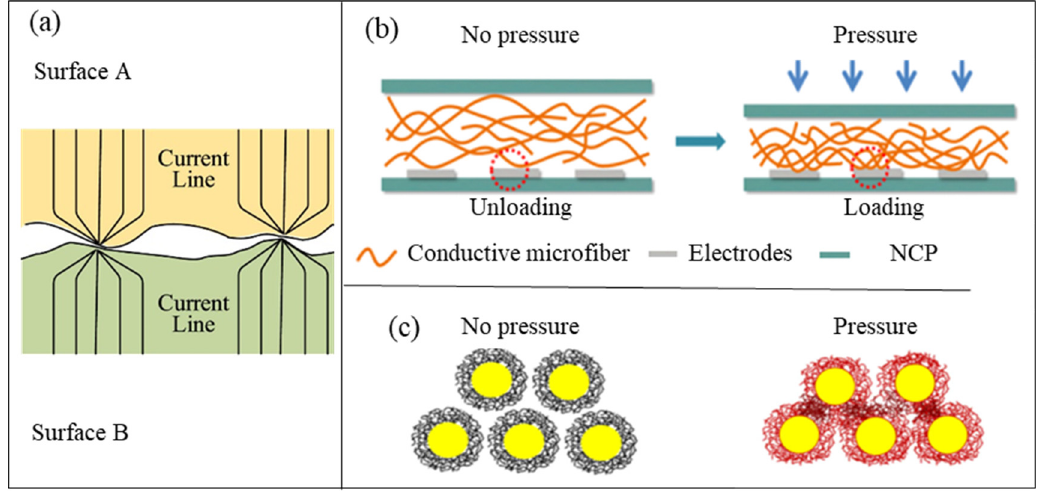
Figure 1. ( a ) conductive paths via the contact points [31] (Copyright 2017, Elsevier Ltd.); ( b ) variation of the contact resistance under pressure [33] (Copyright 2019, American Chemical Society); ( c ) interface effect of CN-coated fibers under external pressure [34] (Copyright 2018, American Chemical Society).